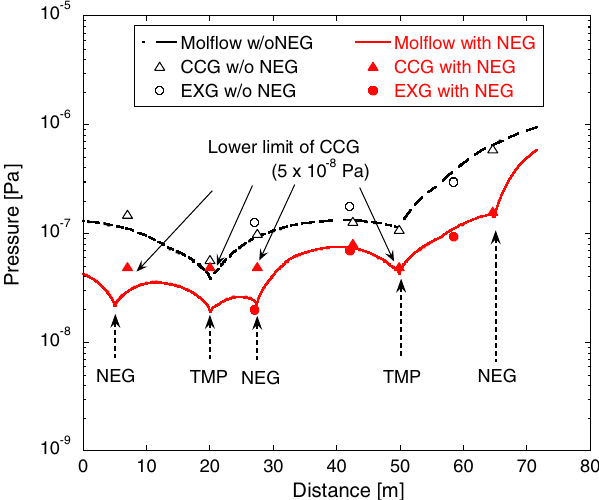
FIG. 26. Result of the buildup test. Time variation of the pressure measured by the CCGs in the second arc section without NEG pumps and the third arc section with NEG pumps. The origin of the horizontal axis is set to the start of the buildup test.